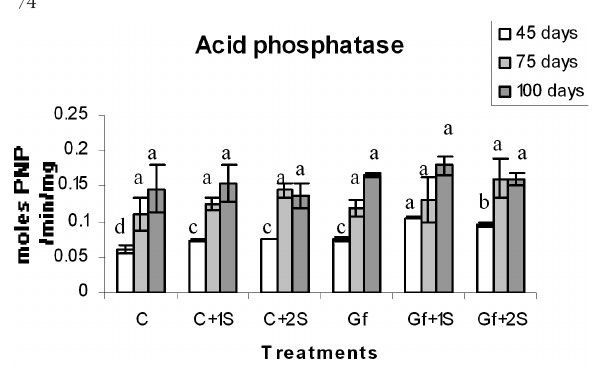
Fig. 3. Acid Phosphatase activity in Gmelina arborea Roxb inoc- ulated with Glomus fasciculatum after 45, 75 and 100 days after AM inoculation